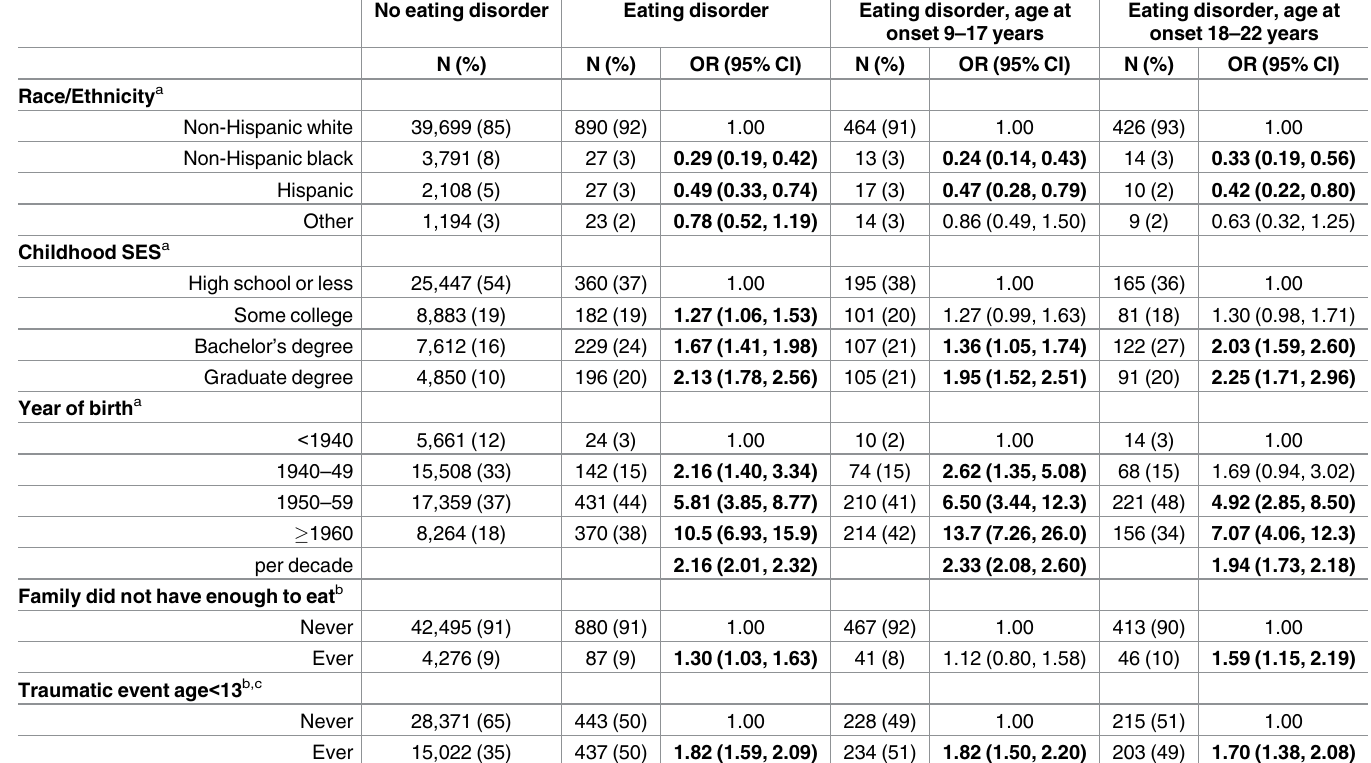
Table 2. Odds ratios (ORs) and 95% confidence intervals (CIs) for history of eating disorders and selected predictors in the Sister Study (n = 47,759).